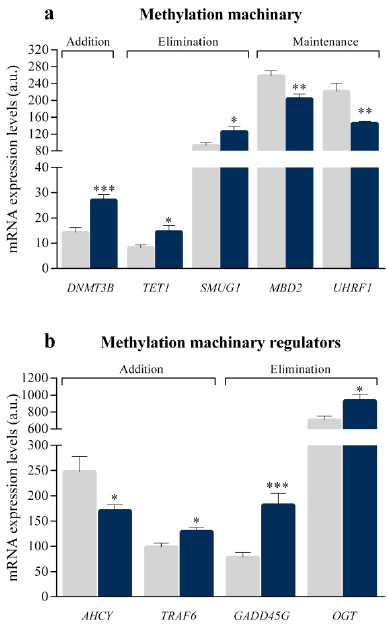
Figure 1. mRNA relative expression levels of altered genes involved in the DNA methylation process in ischaemic hearts versus controls. ( a ) Methylation machinery of DNA: genes related to addition ( DNMT3B ), elimination ( TET1 and SMUG1 ) and maintenance ( MBD2 and UHRF1 ) of methyl groups to DNA. ( b ) Methylation machinery regulators ( AHCY , TRAF6, GADD45G and OGT ). The results were obtained by mRNA ‐ sequencing SOLiD 5500XL platform. Data are presented as the mean ± SEM. a.u., arbitrary units. Ischaemic cardiomyopathy patients ( n = 13; blue), controls subjects ( n = 10; grey). * p < 0.05, ** p < 0.01, *** p < 0.001.